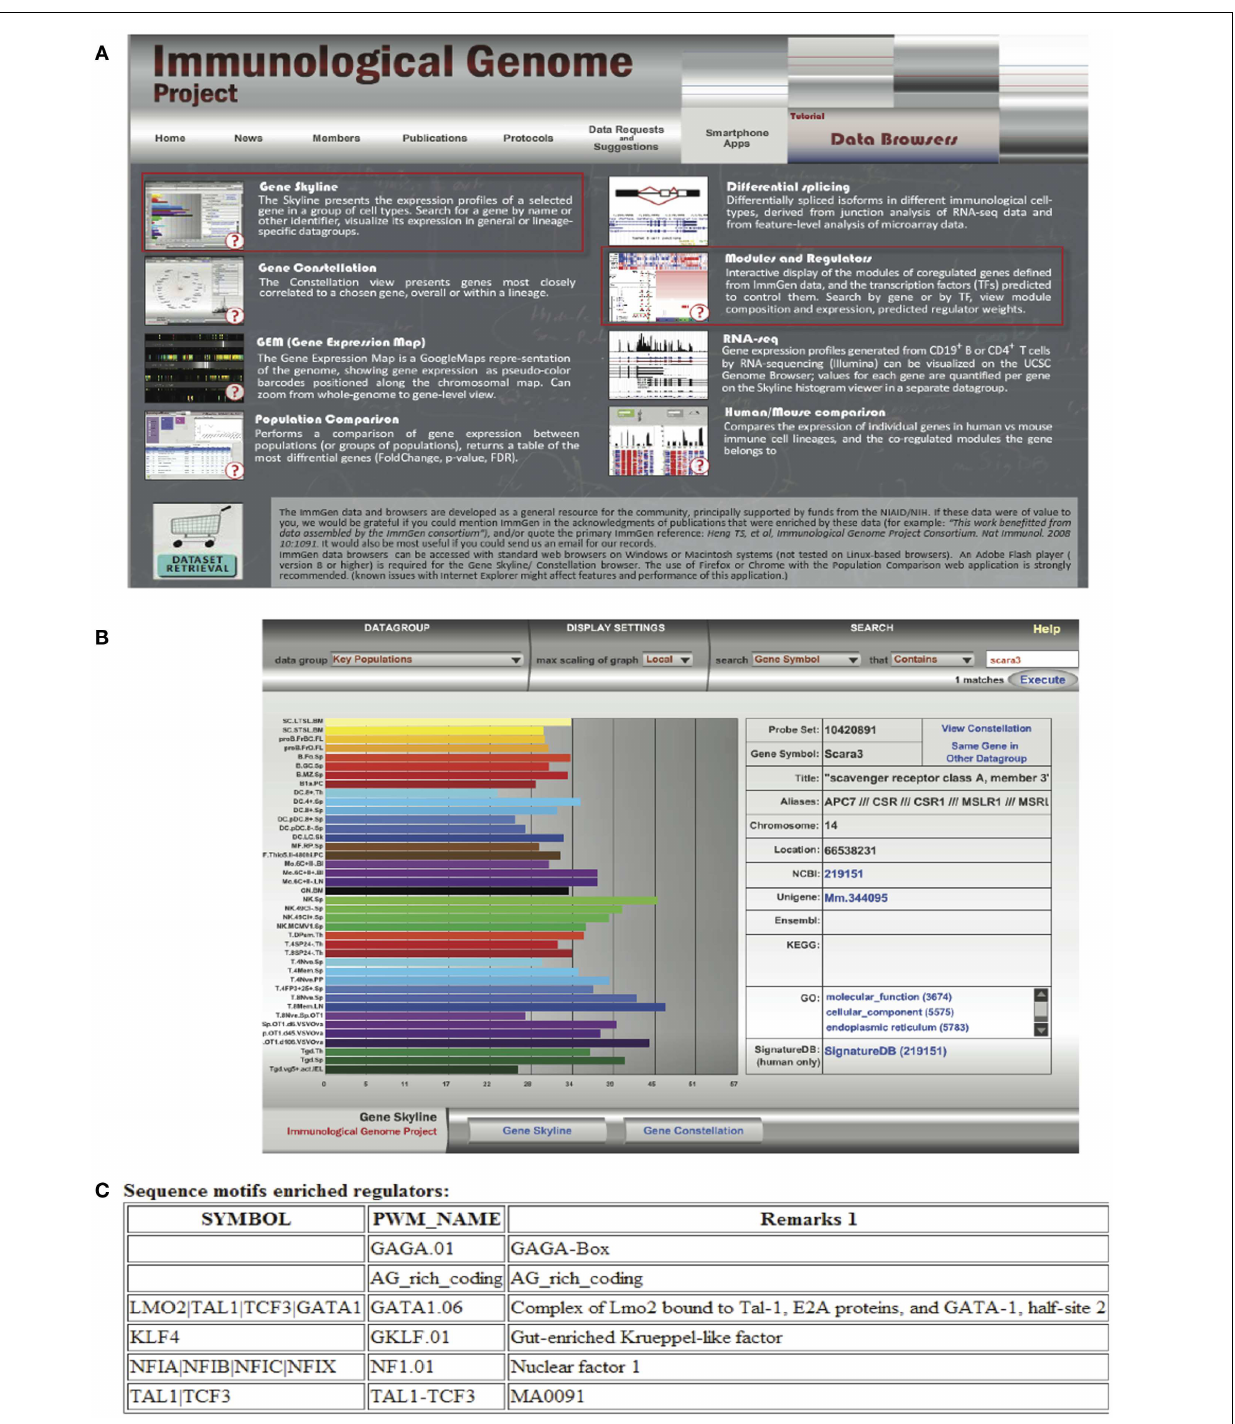
that the transcript for SCARA3 is expressed at low levels in most cell types in the database. (C) Using the “Modules and Regulators” browser we see that there are four predicted transcription factor binding sites (NF1.01, GATA1.06, GKLF.01, andTAL1-TCF3) and two regulatory regions (GAGA.01, AG_rich_coding) in the promotor of